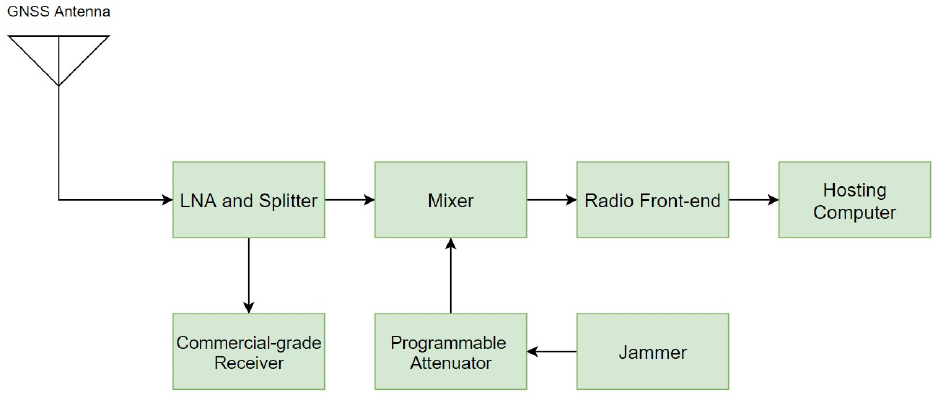
Figure 3. Block diagram of hardware setup used during the data collection on Megastar.